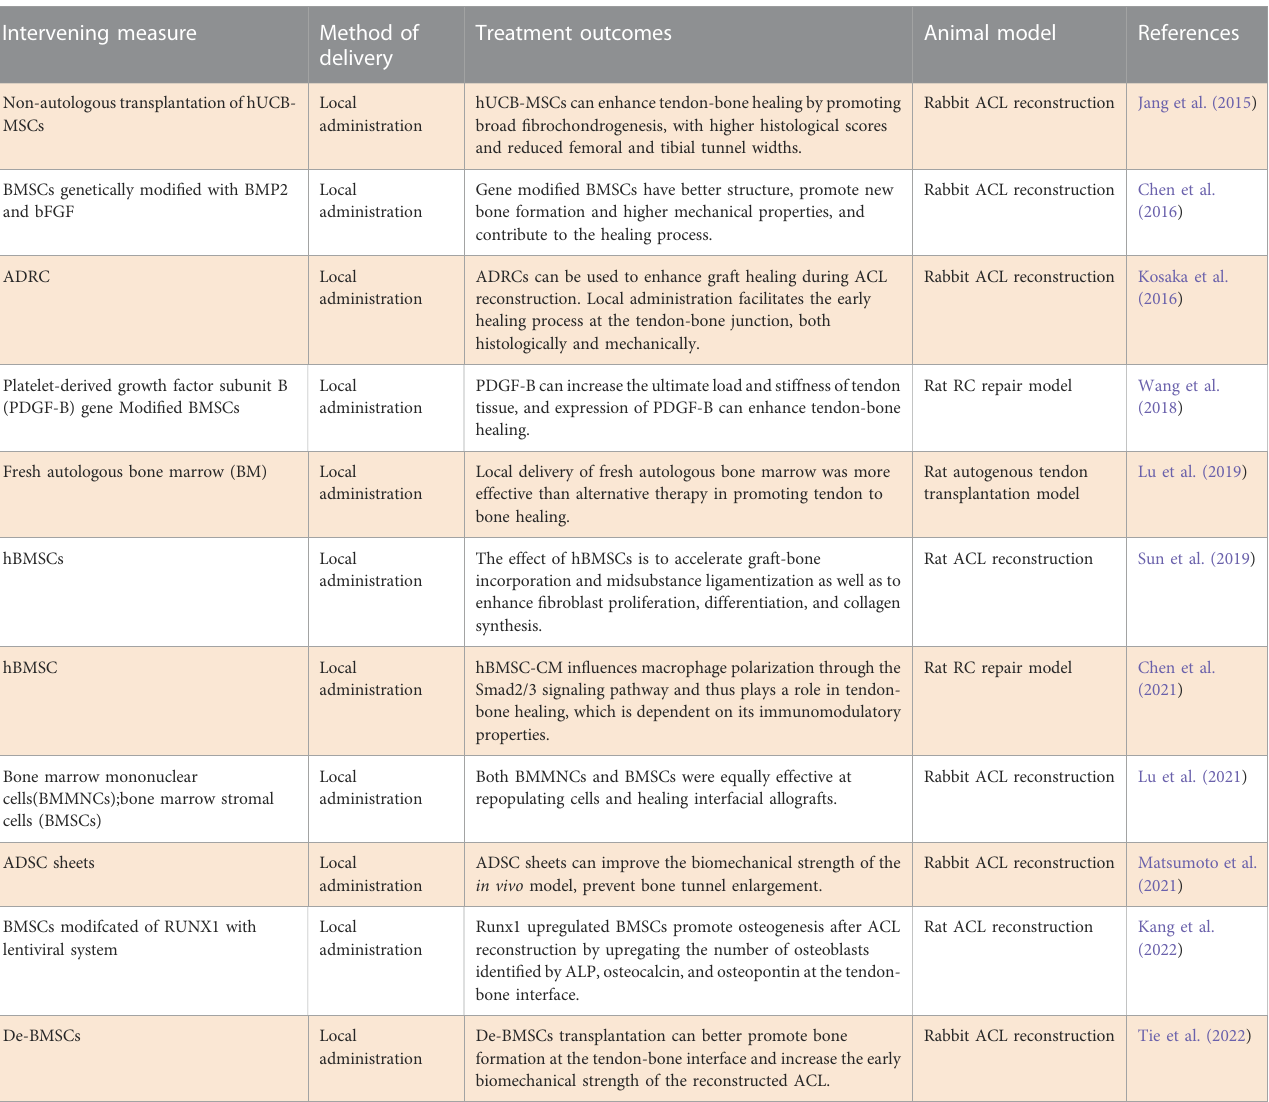
TABLE 2 Preclinical studies of stem cells used to promote tendon-bone